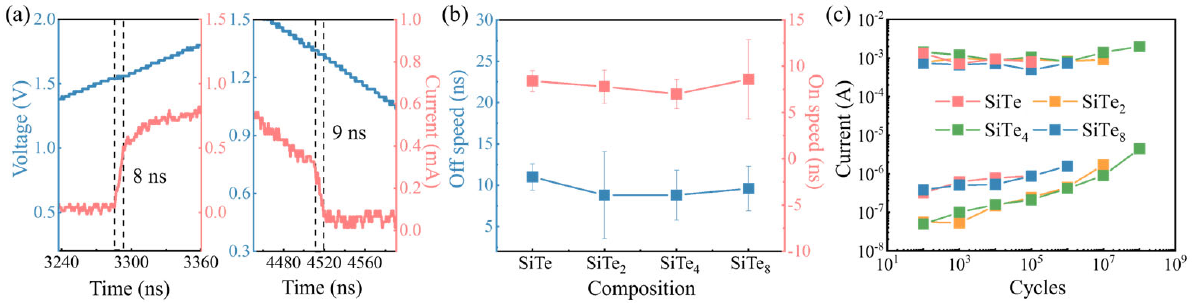
Figure 2. DC curves of devices with different Si contents. ( a ) A 1 k Ω resistor is in series with the device in the DC testing circuit. ( b ) DC I-V curves of Si − Te devices. ( c ) The synthesized DC curves of four compositions.